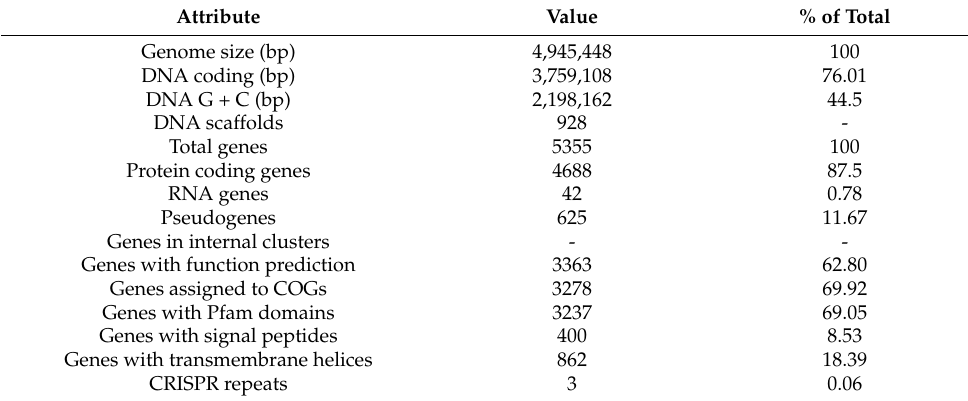
Table 2. Genome statistics of Arthrospira sp. O9.13F.